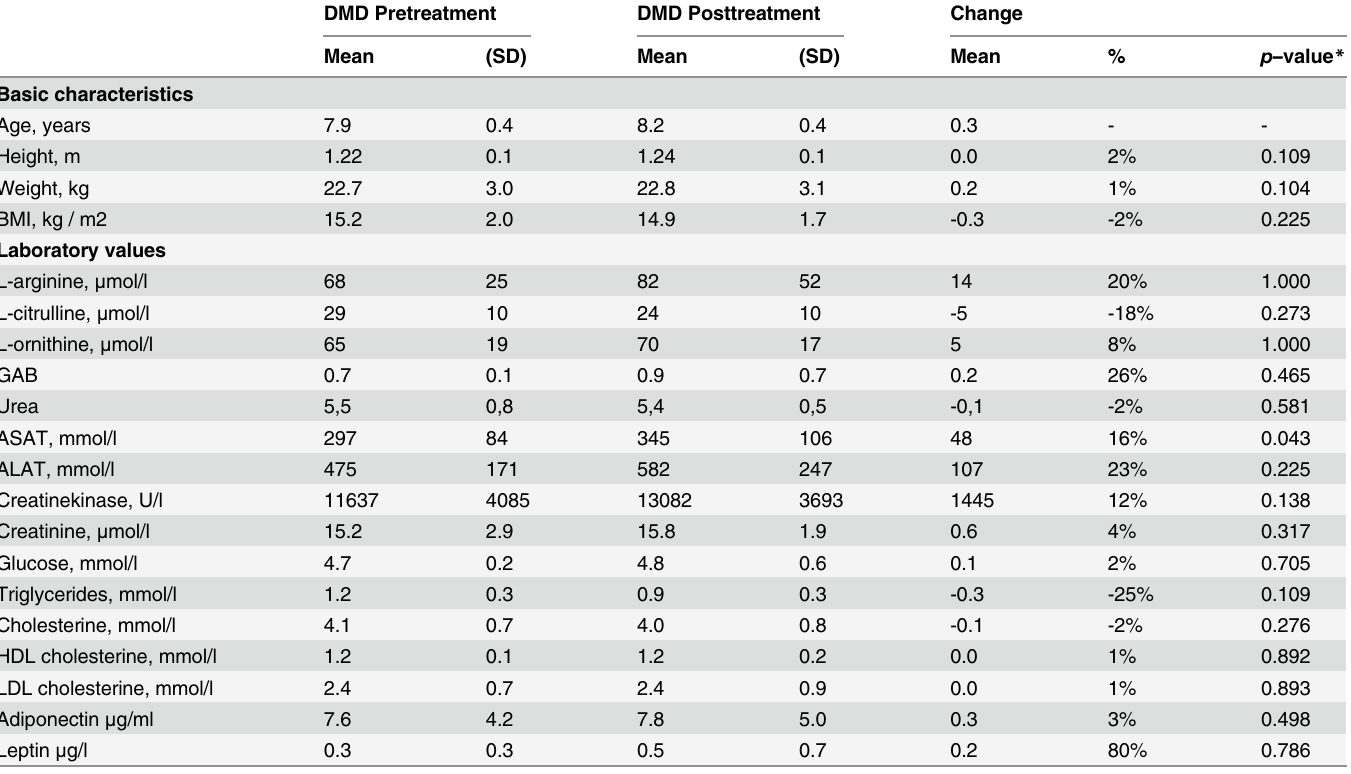
Table 1. Summary of basic characteristics and laboratory